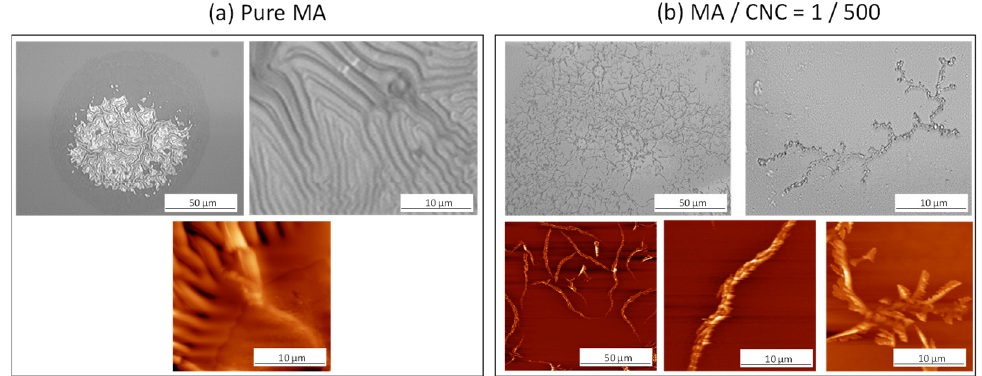
Figure 2. Effect of controlled hydrolysis in controlled moist air (after 4 h) on morphological changes of plasma-polymerized thin films with different composition: ( a ) pure maleic anhydride p(MA) film; ( b ) p(MA+CNC) nanocomposite film with MA/CNC = 1/500, according to optical microscopy ( top row ) and AFM ( bottom row ).